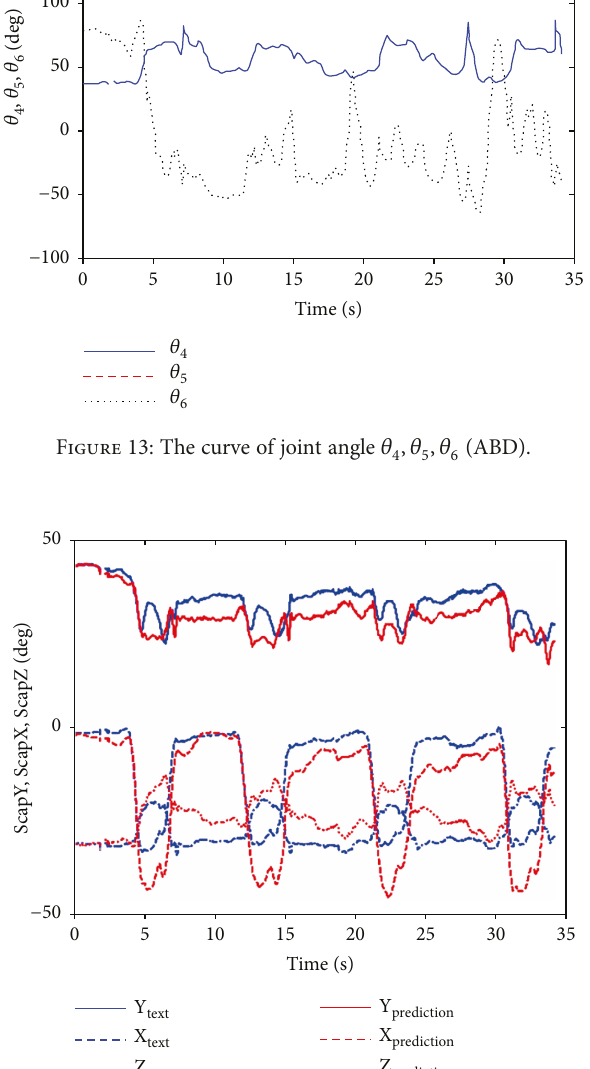
Figure 16: Comparison of lateral rotation obtained by prediction and measurement